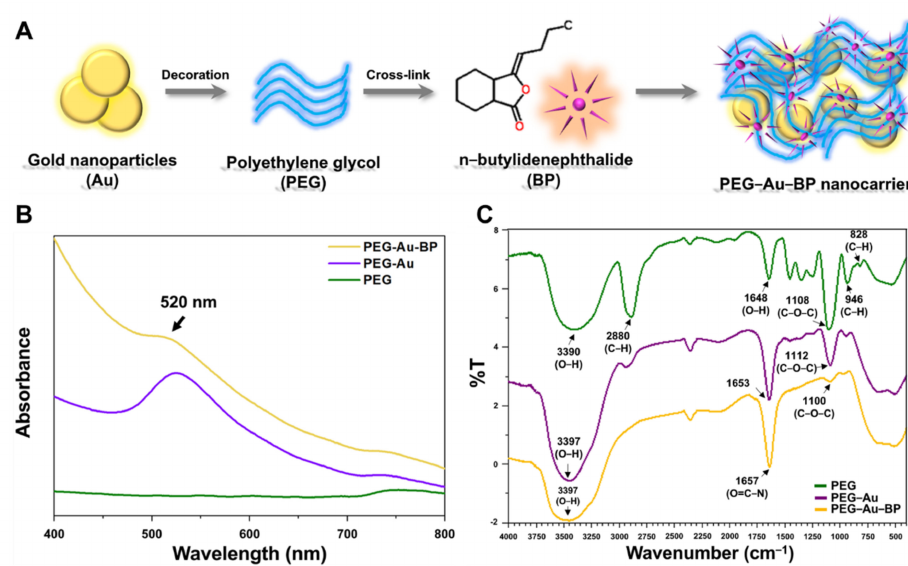
Figure 1. Characterization of PEG-Au nanocarriers cross-linked with BP. ( A ) Concept illustration for the preparation of polyethylene-glycol-gold nanoparticles with n-butylidenephthalide (PEG- Au-BP) nanodrugs. PEG was first combined with Au nanoparticles through sonication. Next, the as-prepared PEG-Au nanocarriers were cross-linked with BP to obtain PEG-Au-BP. ( B ) The UV- Vis spectra demonstrated the presence of Au nanoparticles in PEG-Au and PEG-Au-BP with an absorption peak at 520 nm. ( C ) FTIR spectra indicate the specific functional groups in pure PEG, PEG-Au, and PEG-Au-BP at the total wavenumber from 400 cm − 1 to 4000 cm − 1